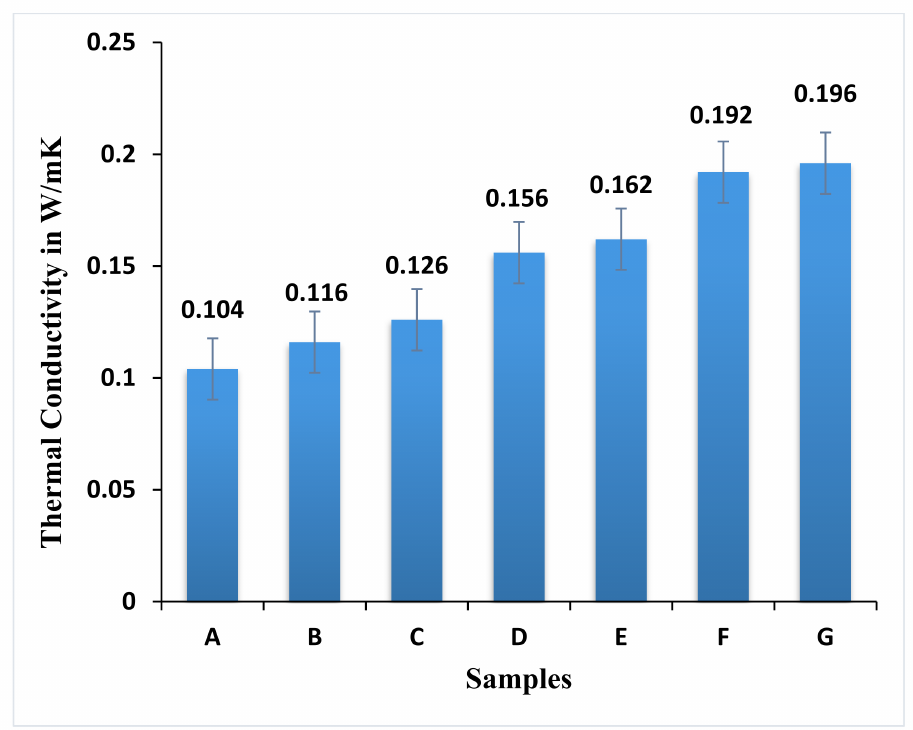
Figure 8. Thermal conductivity of the hybrid epoxy